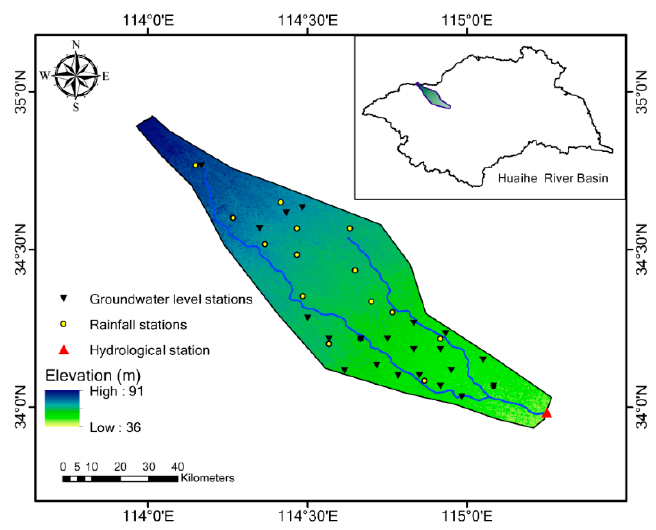
Figure 1. Location of the study area and the stations. Table 1. Characteristics of four growth stages for winter wheat and summer maize.